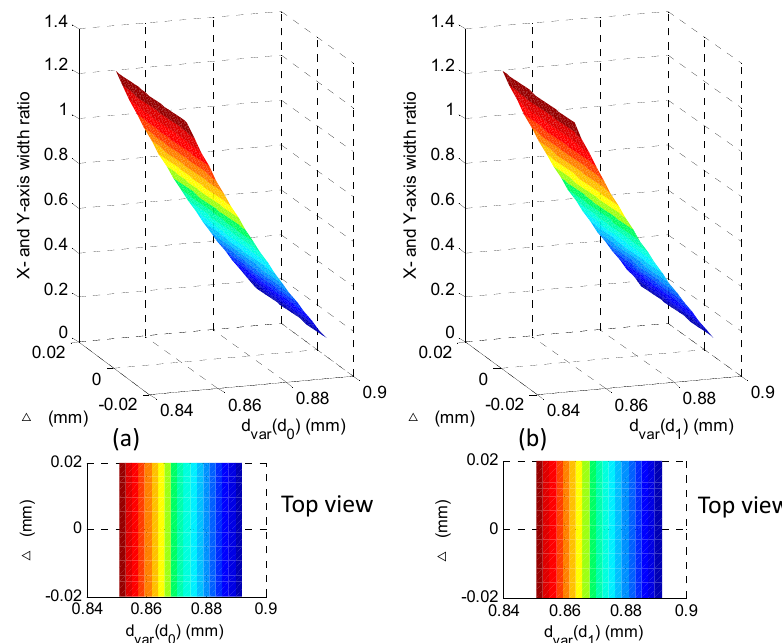
Figure 4. X- and Y-axis width ratios for different d var and coplanar shift values Δ of the point source: ( a ) variation of d var with d 0 , and ( b ) variation of d var with d 1 .